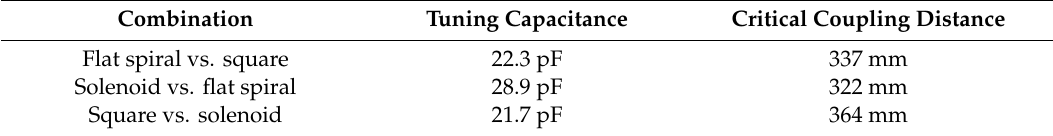
Table 3. Critical coupling distance and tuning capacitance of system under di ff erent coil